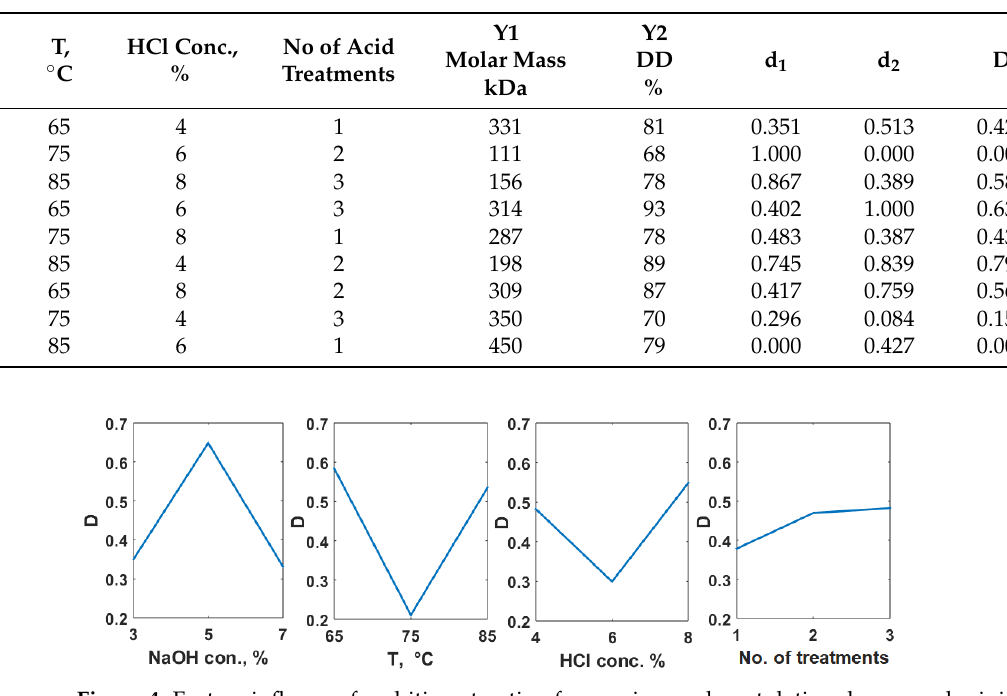
Figure 4. Factors influence for chitin extraction for maximum deacetylation degree and minimum molar mass in